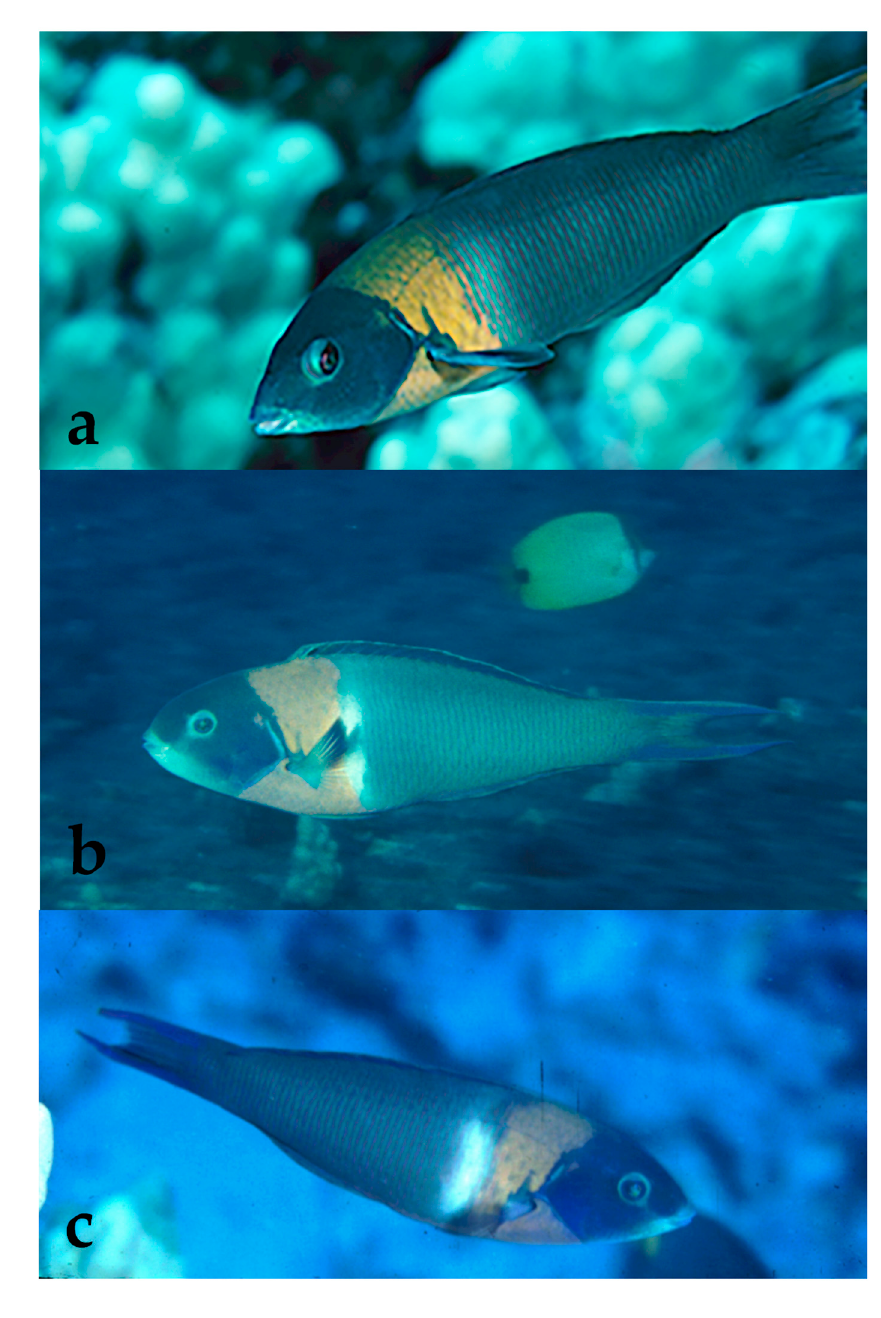
Figure 1. Thalassoma duperrey native to the main Hawaiian Islands ( a , b ) compared to an individual from Johnston Atoll ( c ).